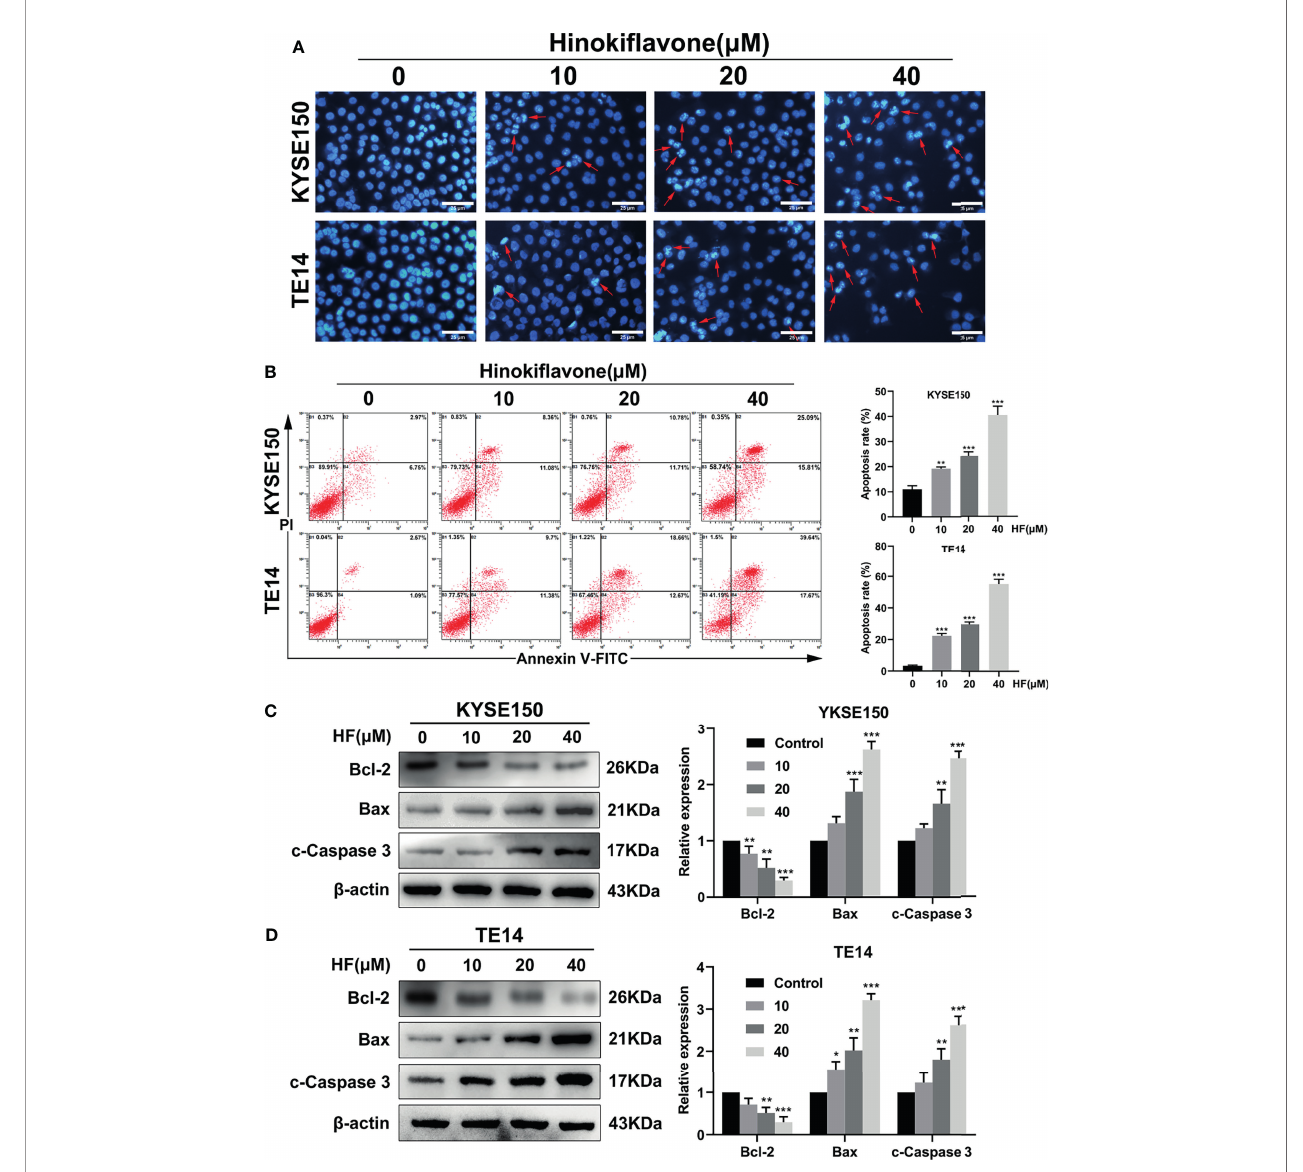
FIGURE 2 | Induction of apoptosis in ESCC cells by HF. (A) Hoechst 33342 nuclear dye was used to stain the KYSE150 and TE14 cells and utilized fl uorescence microscopy to detect HF induced apoptotic nuclear morphological alterations (indicated by red arrows). Magni fi cation, ×200; scale bars = 25 µm. (B) Percentage of KYSE150 and TE14 cells apoptosis after HF treatment was measured using Annexin V- fl uorescein isothiocyanate (FITC)/propidium iodide (PI) double staining and analyzed by fl ow cytometry. (C, D) Expression levels of Bcl-2, Bax, and c-Caspase 3 were detected by western blot and quantitated via densitometric analysis using ImageJ software, while the expression level of b -actin was used as an internal control. The relative expression of experimental histones was calculated according to the protein scale set to 1 for 0 m M control group. All the above experimental data are presented as the mean ± SD of three independent experiments. * P < 0.05; ** P < 0.01; *** P < 0.001 compared to vehicle (0 m M)